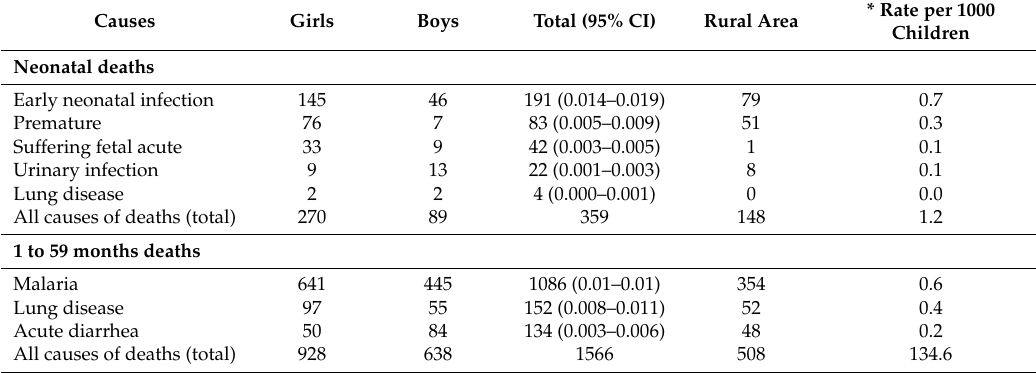
Table 2. Causes of death in neonates (<1 month) and at age 1 to 59 months in Burundi, 2010. Causes